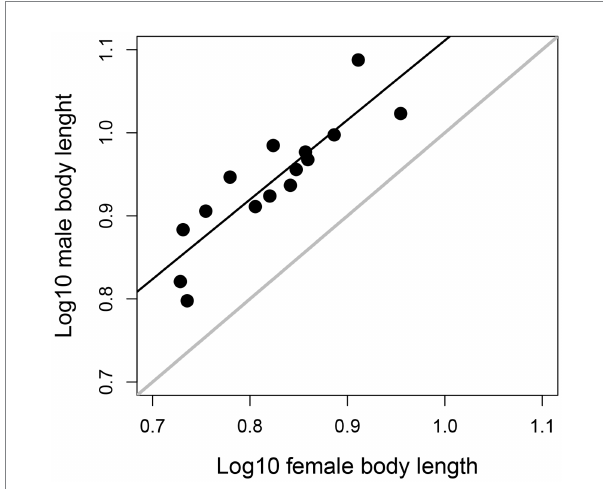
FIGURE 3 Lack of deviation from isometry in male-biased sexual size dimorphism in Asellus aquaticus . Ordinary Least Squares (Model I) regression line ( β = 0.96) and its 95% confidence interval (shaded area) are shown. The thick gray line depicts isometry ( β = 1) without sexual size